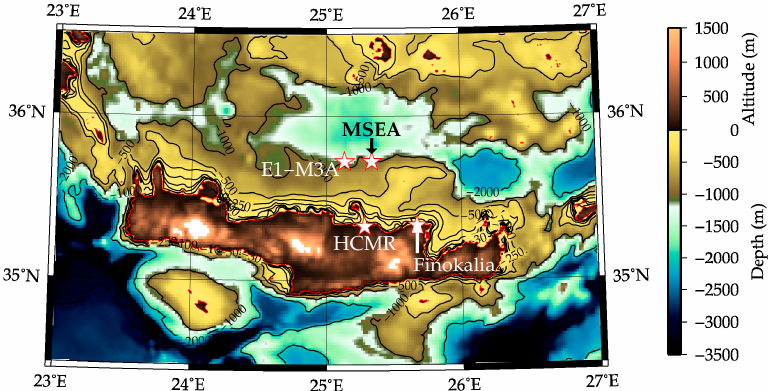
Figure 10. The proposed location of the MSEA site offshore from the Island of Crete, including bathymetry of the area.